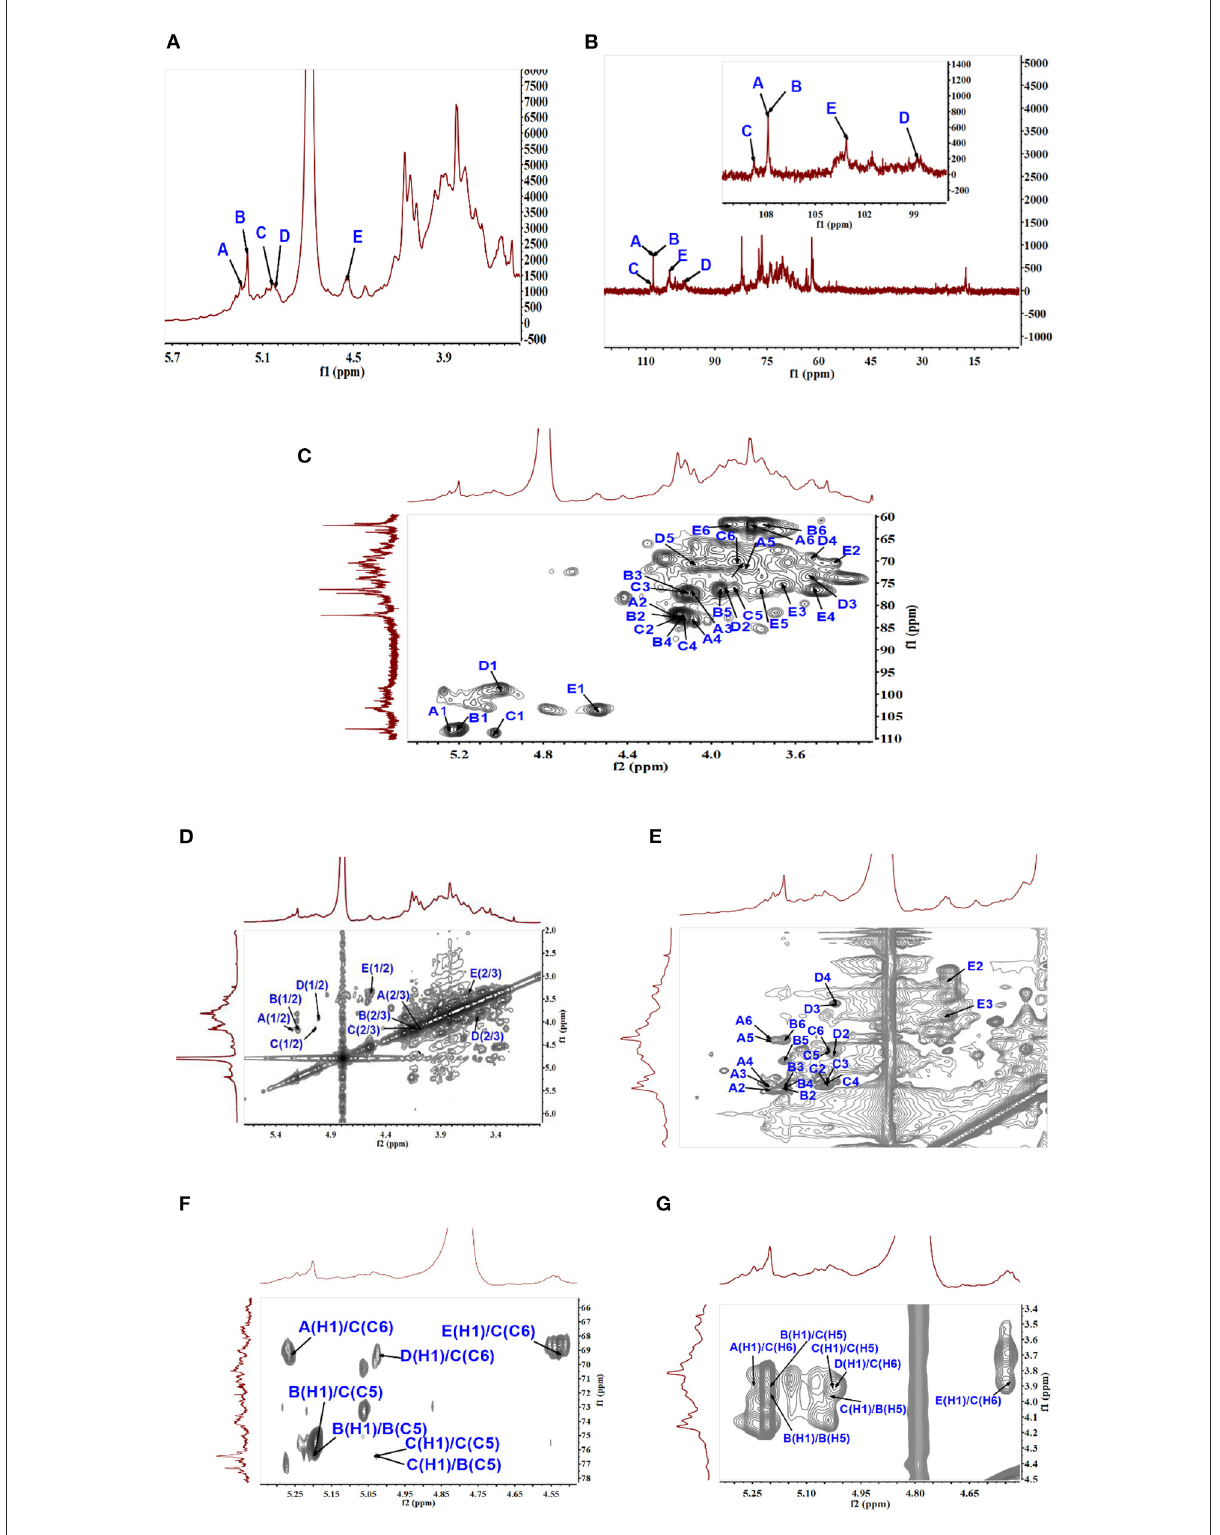
FIGURE2 NMR analysis of SVPS2 structure. (A) 1 H NMR spectroscopy, (B) 13 C spectrum, (C) HSQC spectrum, (D) 1 H- 1 H COZY spectrum, (E) TOCSY spectrum, (F) HMBC spectrum, (G) NOESY spectrum in the anomeric